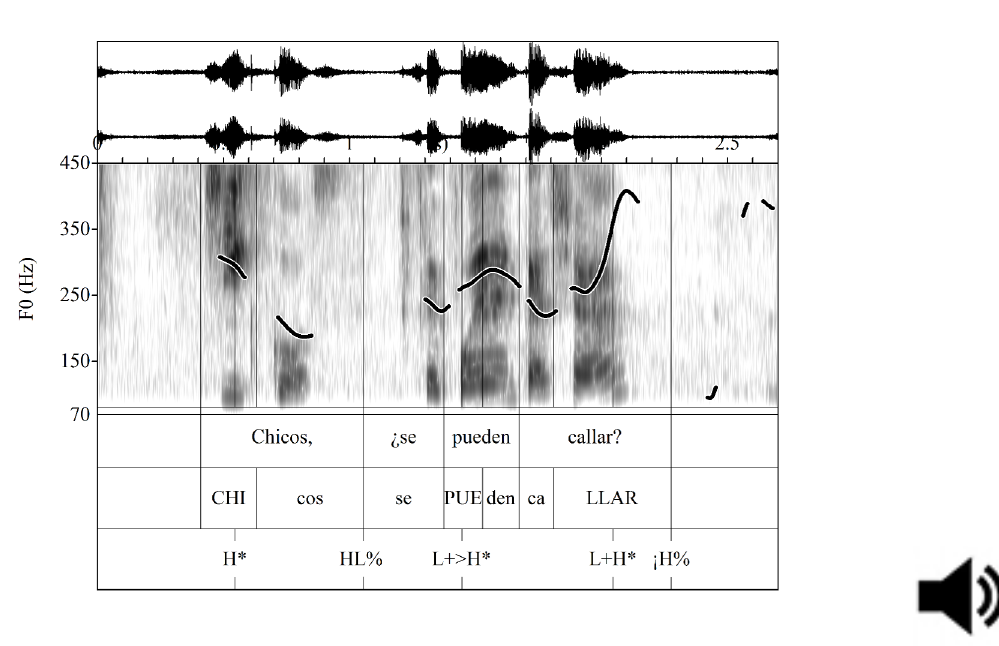
Figure 28 (Participant 10) : Waveform and F0 trace for the vocative within the imperative yes-no question ¿ Chicos, se pueden callar? ‘Kids, can you please be quiet?’ produced as one IP realized as H* (nuclear accent) and HL% (boundary